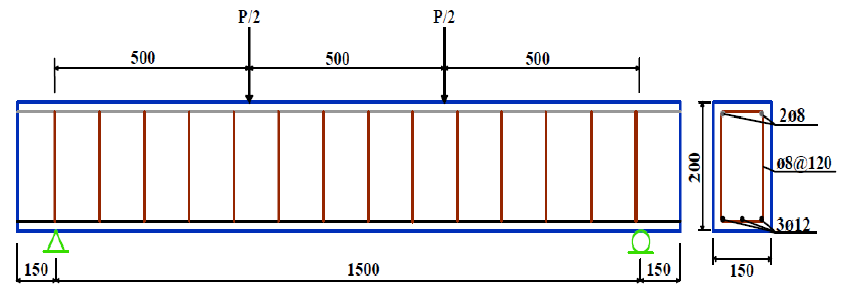
Figure 10. Detailed Geometry of Banjara and Ramanjeyulu Specimen (C) [50].